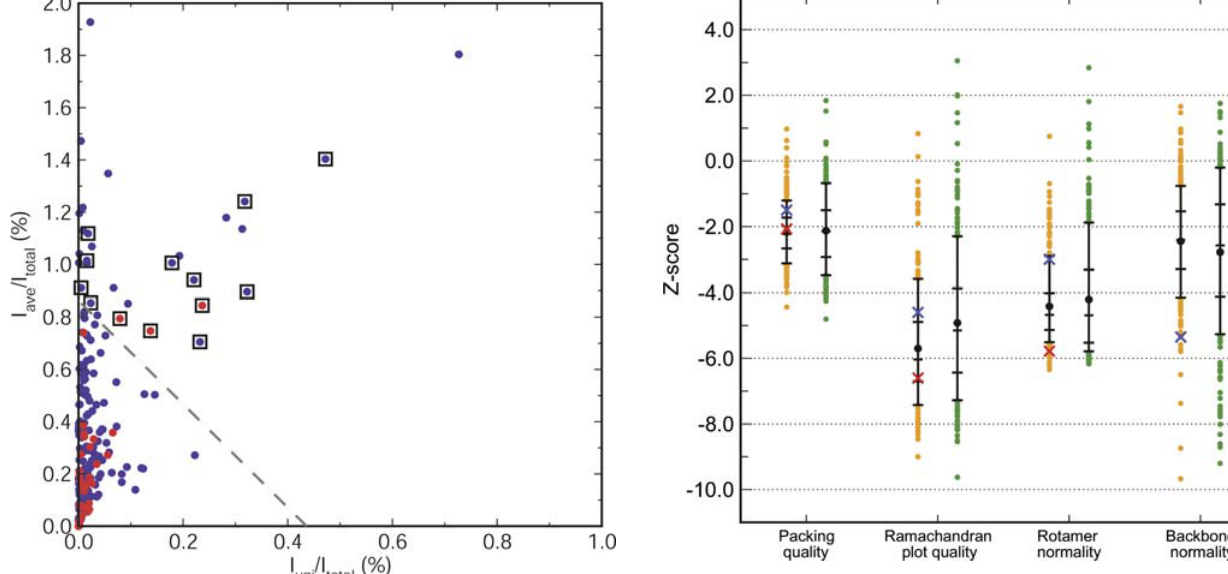
Figure 4. Structure Quality Z -Scores for a Large Set of Recent NMR Structures The quality scores of 620 NMR ensembles released from the PDB after January 1, 2003, are shown. For comparison, the dataset is separated in structures solved as part of structural genomics projects (orange) and structures originating from individual research groups (green). For each quality indicator, the average Z -score is indicated with a filled black circle. The black horizontal markers indicate (from top to bottom) the 90th, 75th, 50th (the median), 25th, and 10th percentiles of the data points for each quality indicator. The distribution of the outliers outside the markers is indicated using colored data points. The quality scores of the original and refined 1TGQ ensemble (cf. Table 1) are indicated by red and blue crosses, respectively. The backbone normality score of 1TGQ is identical for the original and refined ensemble. DOI: